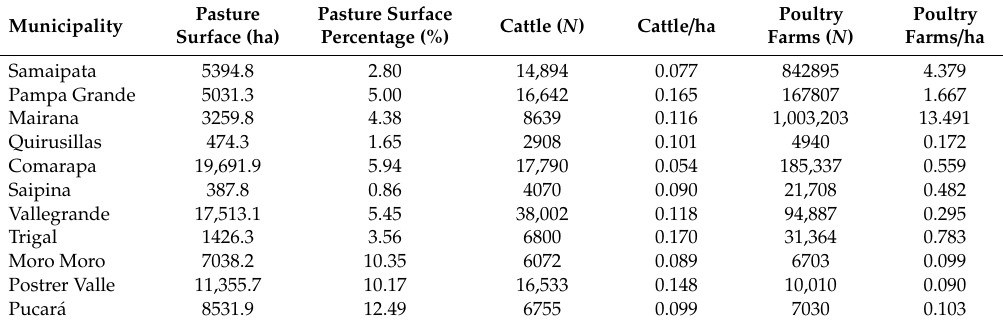
Table 8. Animal husbandry data in the di ff erent municipalities of the study area Municipality